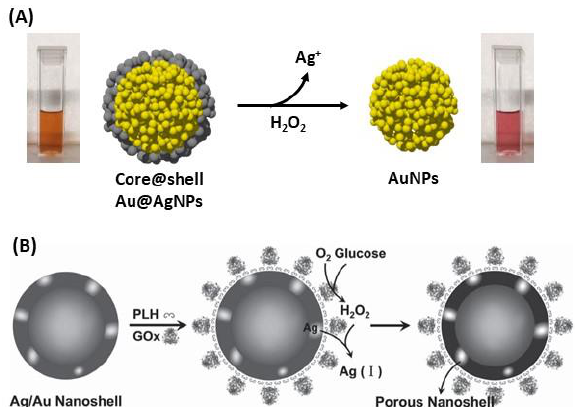
Figure 30. ( A ) Illustration showing the oxidation of Ag shell on Au@Ag core@shell NPs to Ag + in the presence of H 2 O 2 produced by an enzymatic reaction. ( B ) Schematic illustration showing the glucose sensing mechanism with Ag/Au nanoshells. Adapted from [198]. Copyright (2012) WILEY‐VCH Verlag GmbH & Co. KGaA, Weinheim.